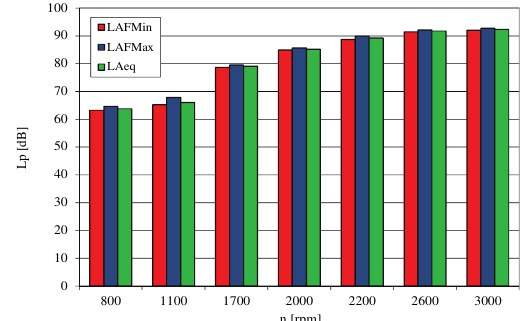
Fig. 3. The equivalent acoustic pressure level (L Aeq ) changes for different engine speeds Observing the mean, RMS, peak, peak-to-peak point es- timators of the vibration accelerations one can find that there is a strict function relation between the engine speed increase and the change of the above point measure (Figs 4 - 6). The point measures values, obtained for a combustion process, increases when engine speed rises, no matter what measurement dimension is considered. The highest values were obtained for Z dimension. Comparing such results with the peak and peak-to-peak values for the combustion process time run sections it is obvious the above two di- mensional point measures of the vibration accelerations have the highest sensitivity for combustion process changes in the relation with the engine speed factor. Comparing of all point measures taken into considera- tion for a Z dimension one can perceive the peak and peak- to-peak values are the most sensitive measures for combus- tion process changes resulting from engine speed increase. That means also the incorrect processes that might appear in the normal combustion engine operation will be une- quivocally detected and